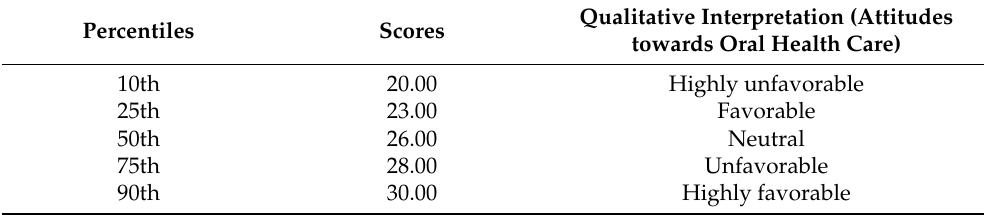
Table 2. Percentiles for the DNS.